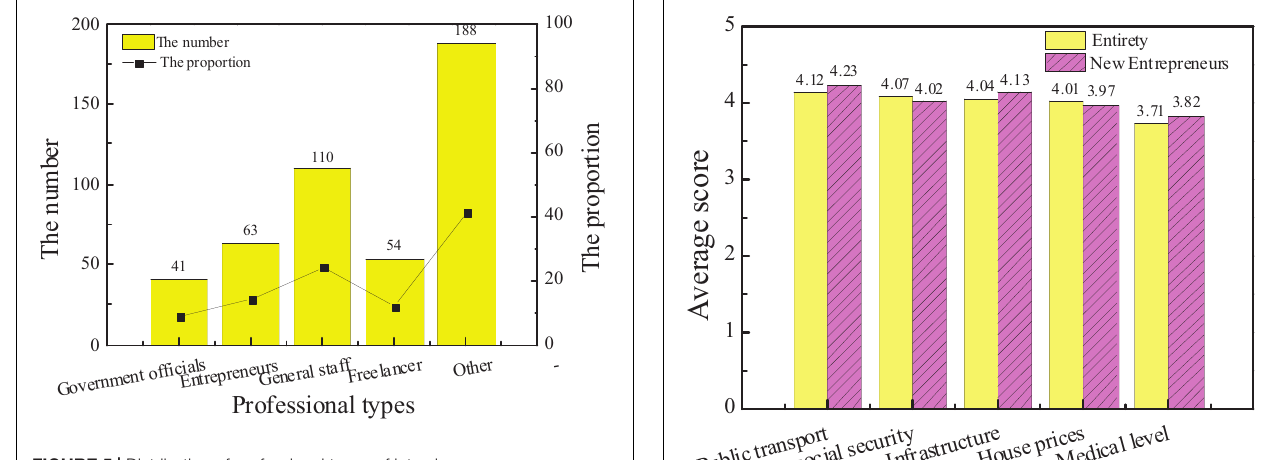
FIGURE 5 | Distribution of professional types of interviewees.